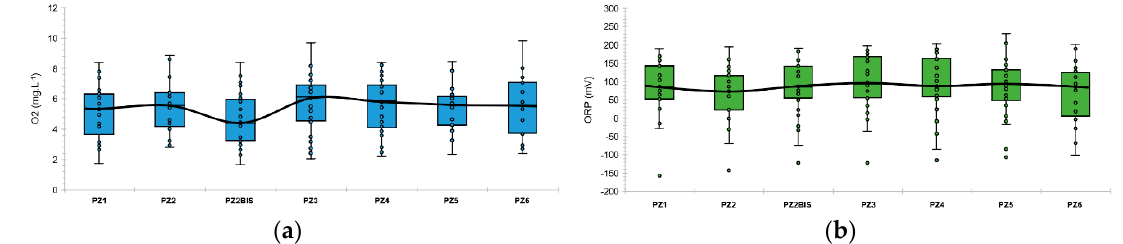
Figure 3. Boxplots of dissolved oxygen concentration and oxidation-reduction potential along the experimental site during the baseline: ( a ) Dissolved oxygen concentration; ( b ) oxidation-reduction potential. The colored boxes represent the 1st and 3rd quartiles (respectively Q1 and Q3), the black line is the median line, the dots are the measured values, the whiskers are the upper and lower extreme limits calculated according to the Tukey’s formula: Q1 + 1.5 (Q3 − Q1) and Q3 − 1.5 (Q3 − Q1).